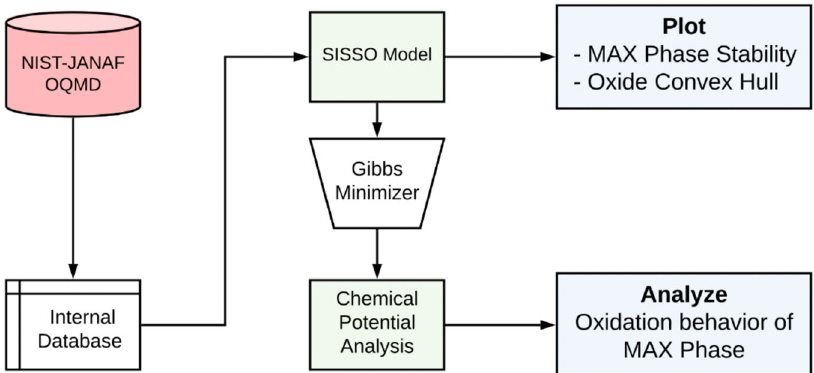
Fig. 11 Schematic representation of the work fl ow. The SISSO and GCLP-based machine-learning work fl ow to predict oxide phase selection and stability of MAX